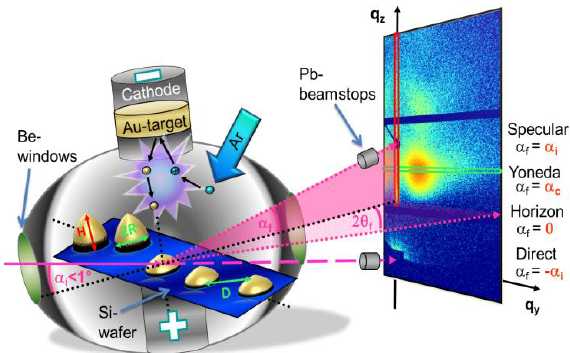
Figure 1. Scheme of an in situ sputter deposition experiment combined with grazing incidence small-angle X-ray scattering (GISAXS). The angle between the incident monochromatic X-ray beam and the sample surface is denoted by α i , the corresponding exit angle by α f , and the out-of-plane angle by 2θ f . A reciprocal space (q y , q z ) coordinate systems is indicated. The origin of coordinates of q y and q z is indicated by the direct beam positions. The red and green rectangles in the 2D GISAXS pattern mark the region of the detector cut and out-of-plane cut, respectively. Adapted from reference [133] with permission from the Royal Society of Chemistry, 2013.